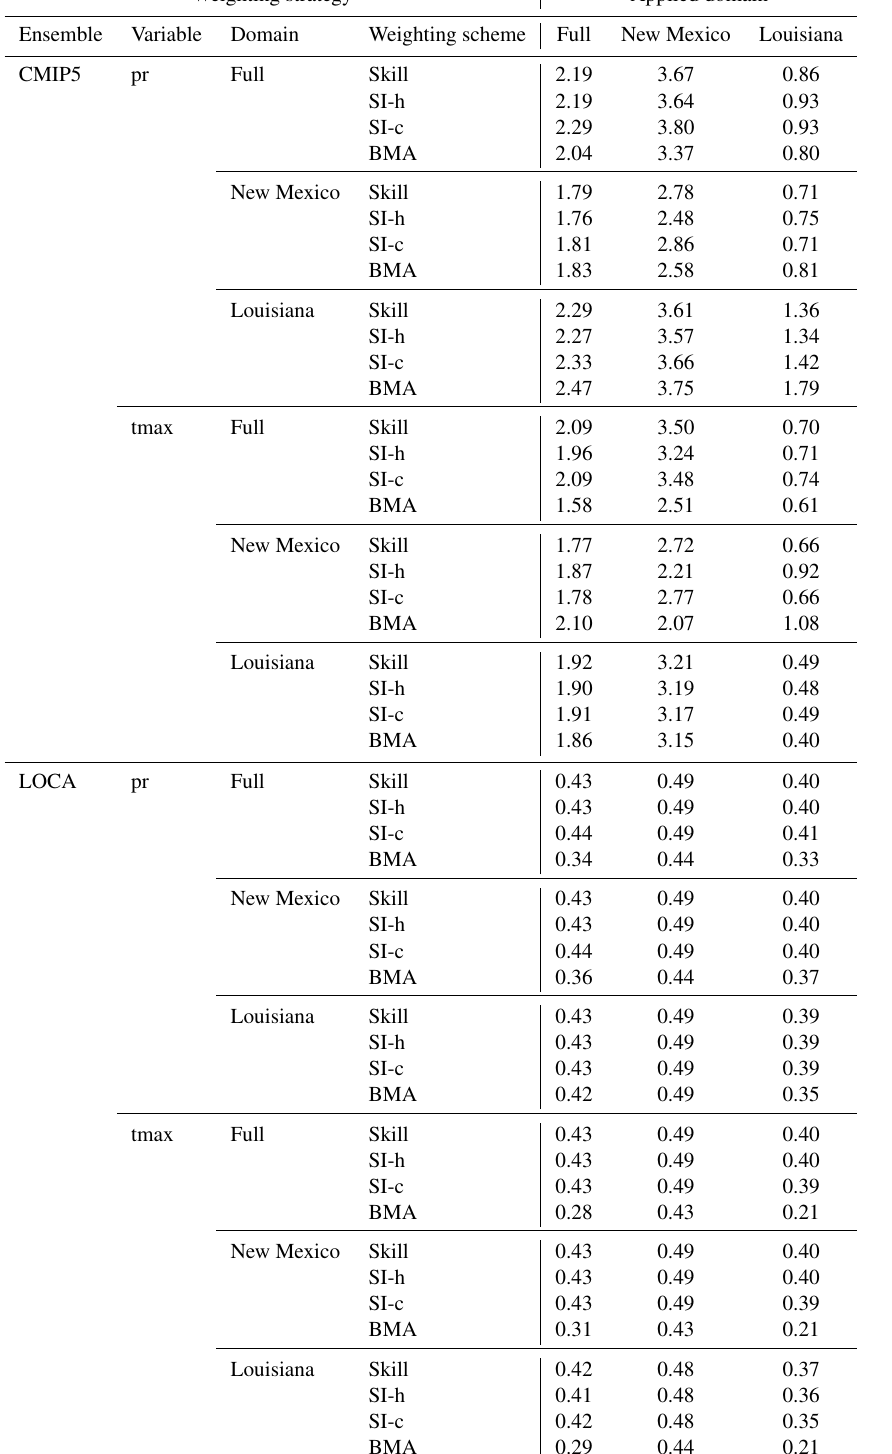
Table 3. RMSE ( ◦ C) of daily precipitation for each weighting strategy applied in all three domains. Weighting strategies include the weight- ing scheme and the ensemble, variable, and domain used to derive model